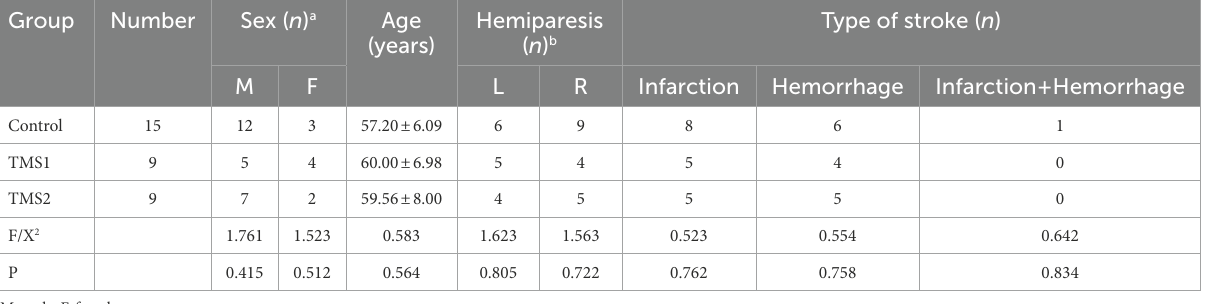
TABLE 2 Comparison of general data of the three group. Group